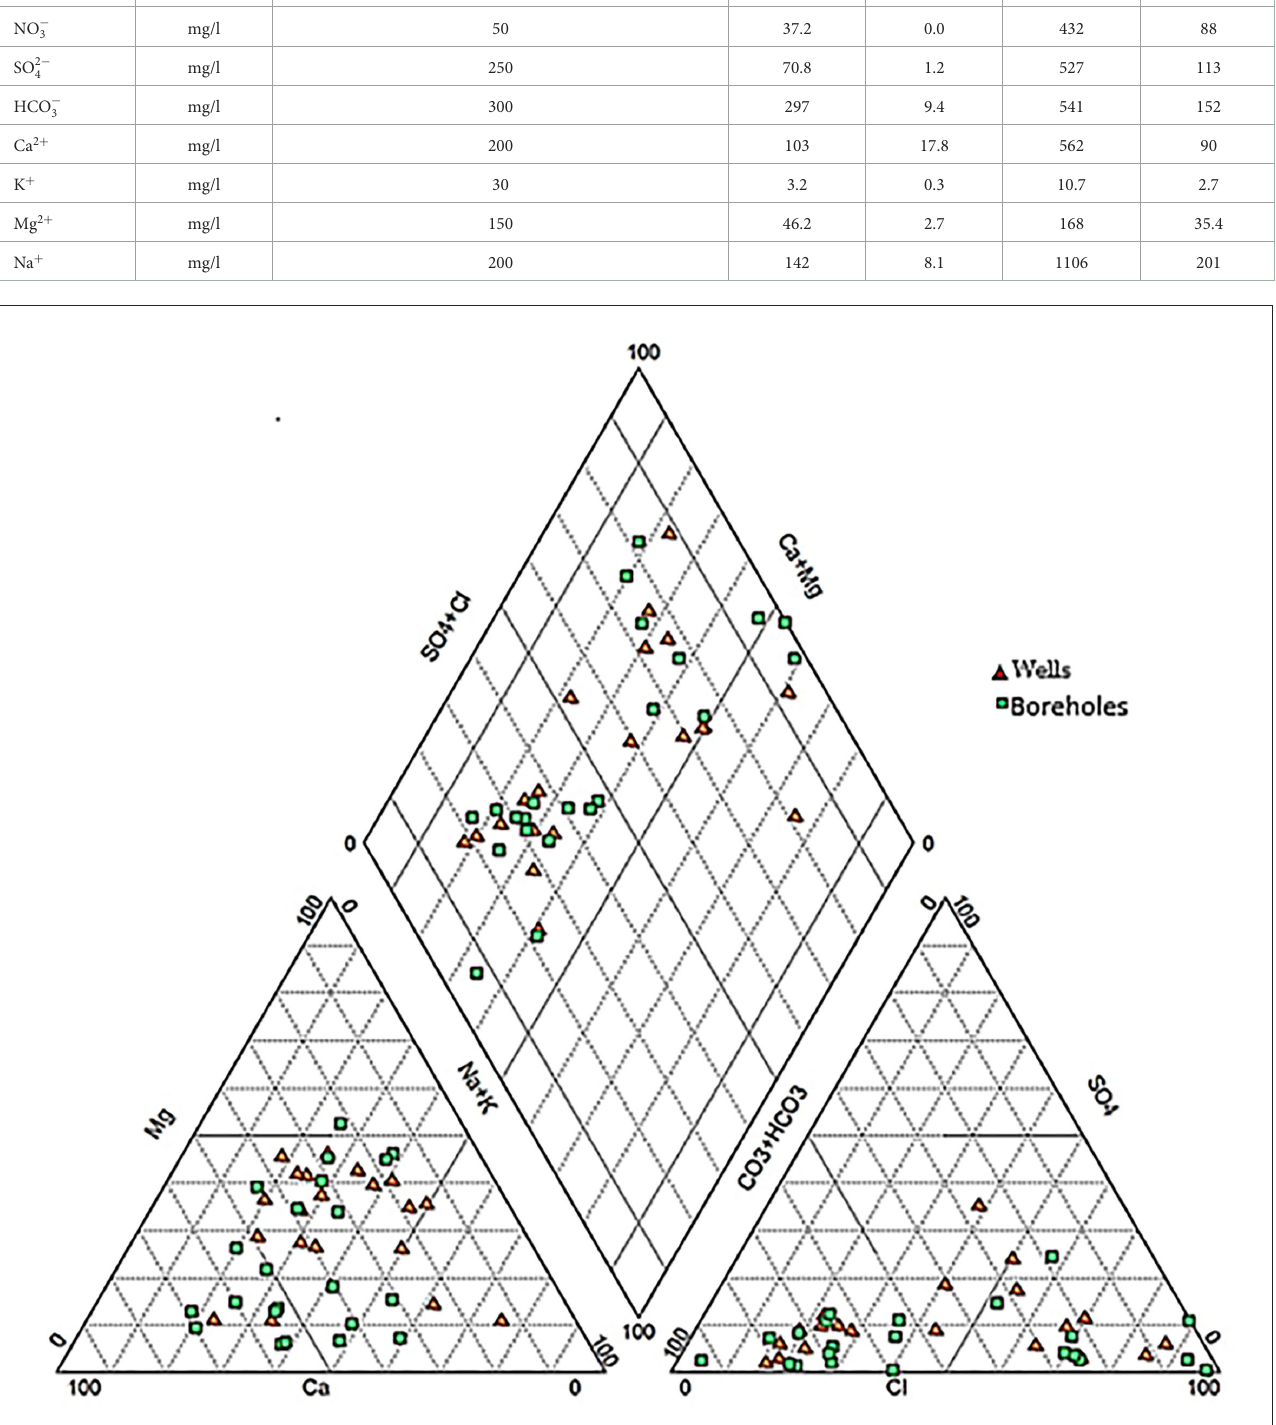
FIGURE3 Piper diagram of the groundwater samples of the study